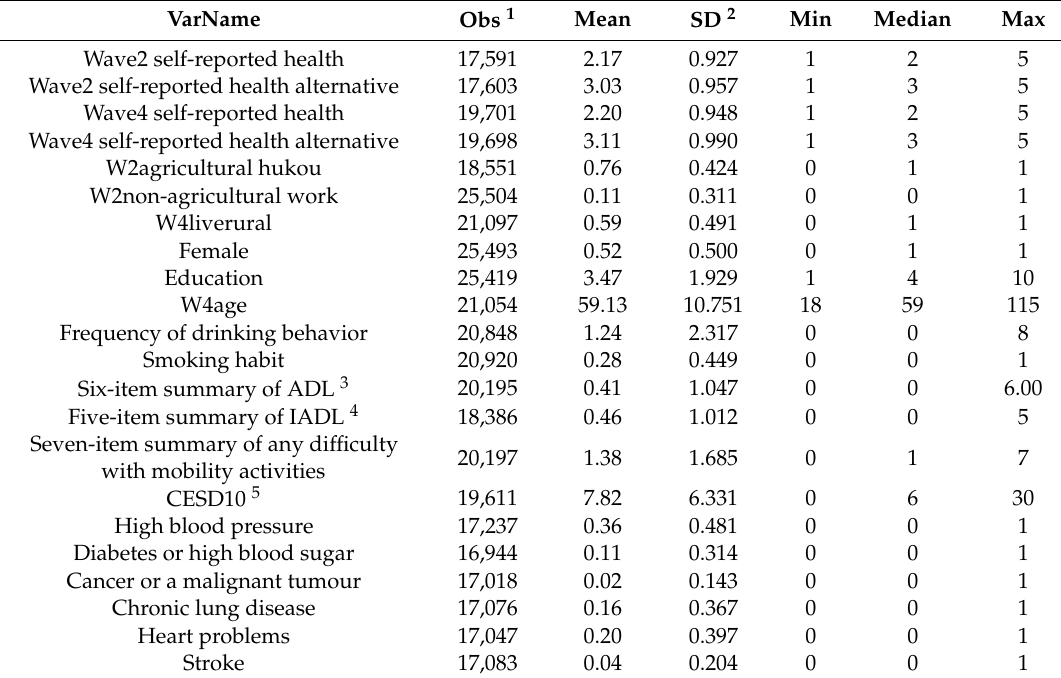
Table 2. Descriptive statistics of key variables in Harmonized